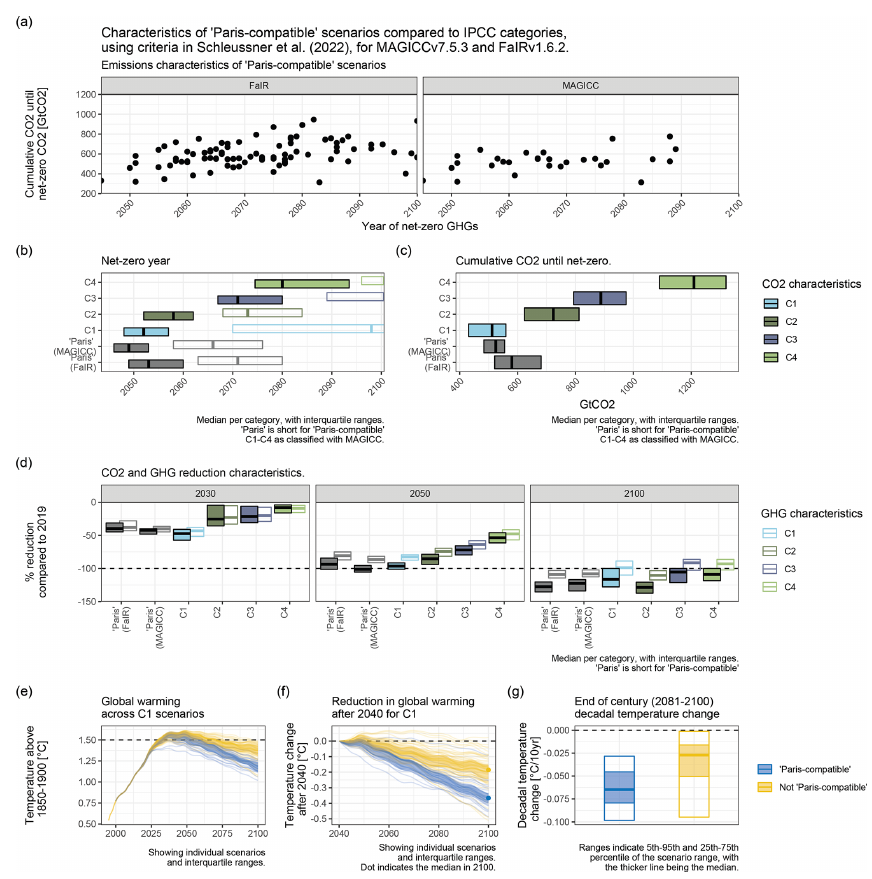
Figure 6. Characteristics of “Paris-compatible” scenarios using the FaIR and MAGICC emulators compared to the C1–C4 categories from IPCC AR6 WGIII, which used the MAGICC emulator for classification. “Paris” here is short for “Paris-compatible” and uses the criteria from Schleussner et al. (2022), being (a) “not ever having a greater than 66% probability of overshooting 1.5 ◦ C”, (b) “ very likely (90% chance or more) [...] not ever exceeding 2 ◦ C”, and (c) achieving net-zero greenhouse gas emissions using global warming potentials over a 100-year period (GWP100). Panels (e) – (f) are based only on